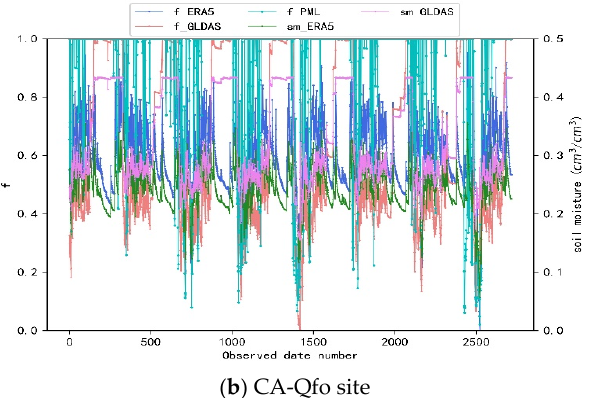
Figure 4. The variation process of 𝑓 obtained by different methods and SM values.